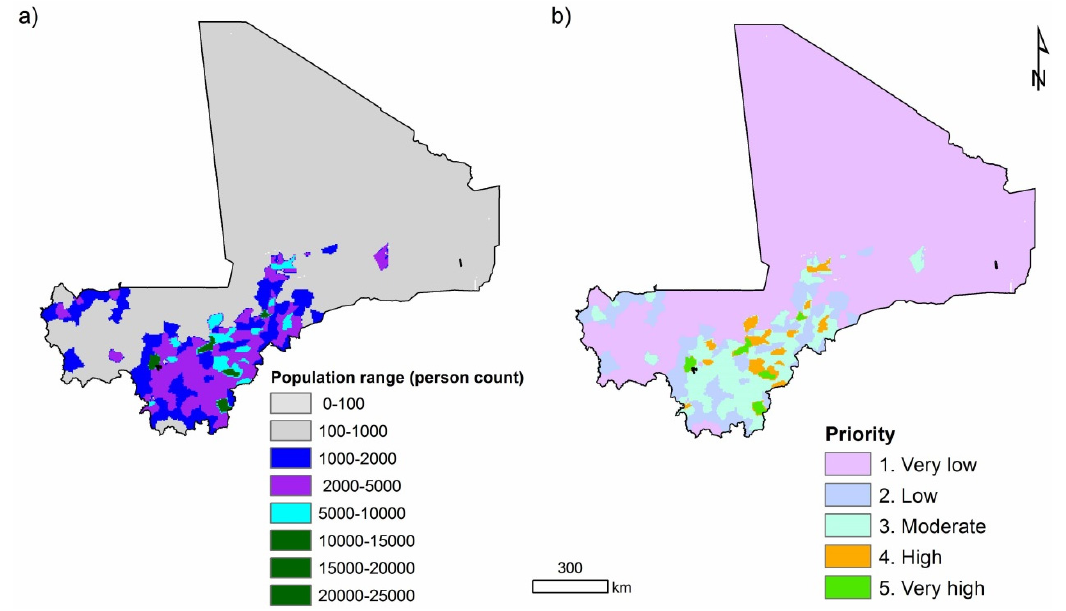
Figure 4. Spatial distribution of Population in Mali: ( a ) population count; and ( b ) priority category. Water 2016 , 8 , 260